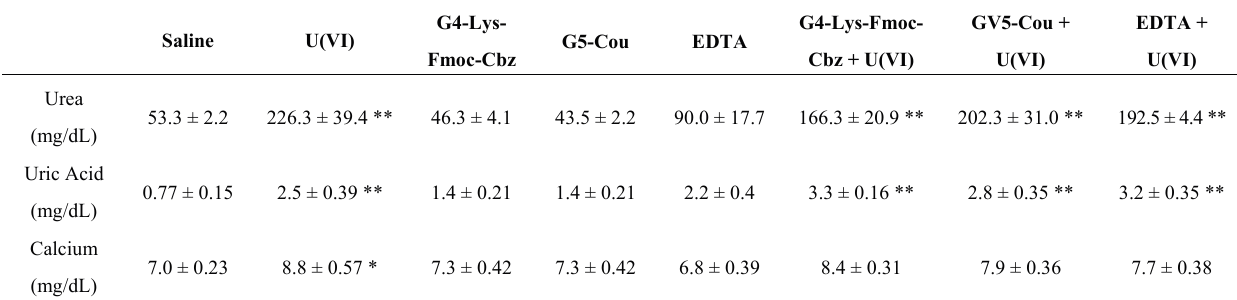
Table 4. Plasma concentration of urea, uric acid and calcium in the different study groups.